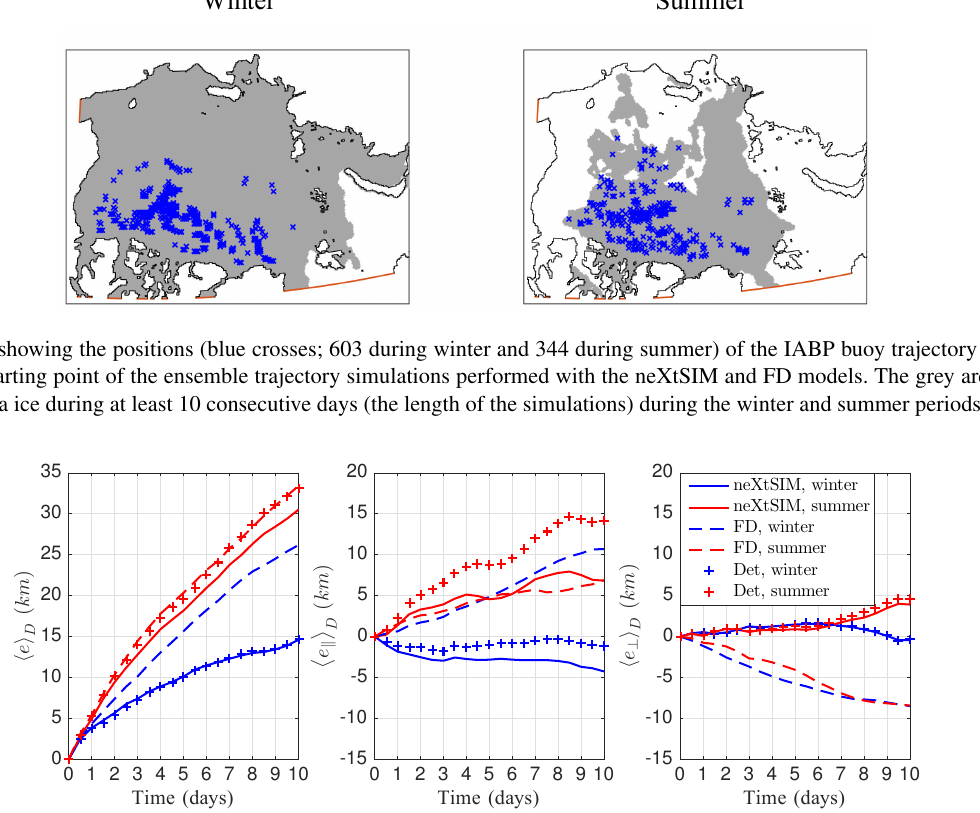
Figure 15. Mean of the absolute forecast error (cid:107) e (cid:107) and vector components e (cid:107) and e ⊥ in the directions along and across the mean trajectory, as a function of drift duration. neXtSIM is represented by solid lines, FD is shown as dashed lines, and the deterministic runs with cross marks. Winter is in blue and summer in red. A positive e ⊥ represents a drift to the left of the